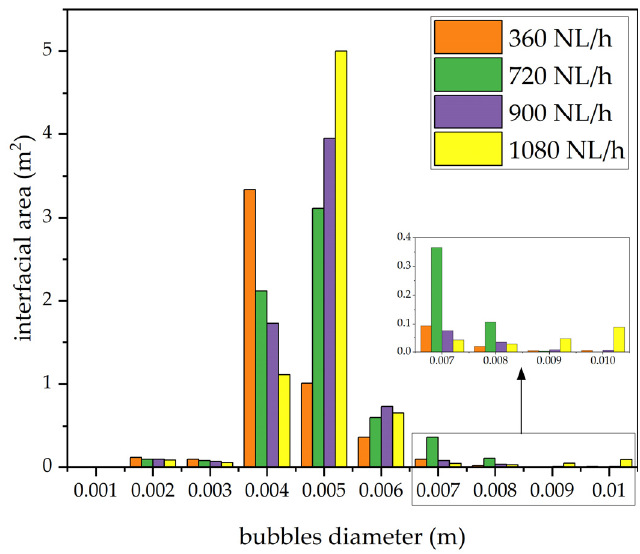
Figure 10. The interfacial area at different flow rates.